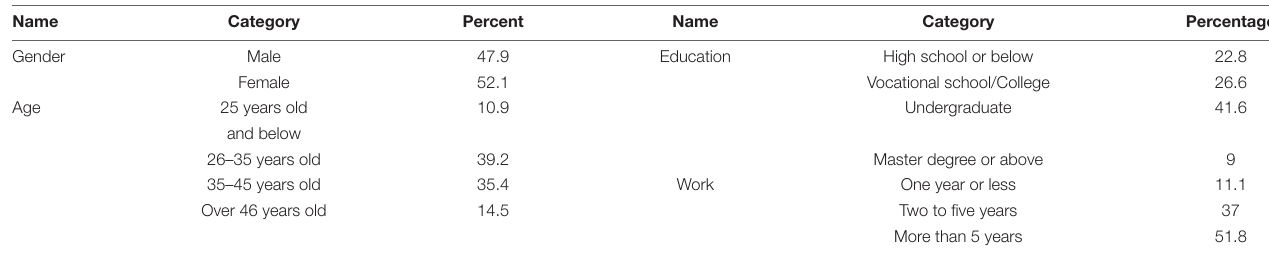
TABLE 4 | Composition of valid samples ( N =